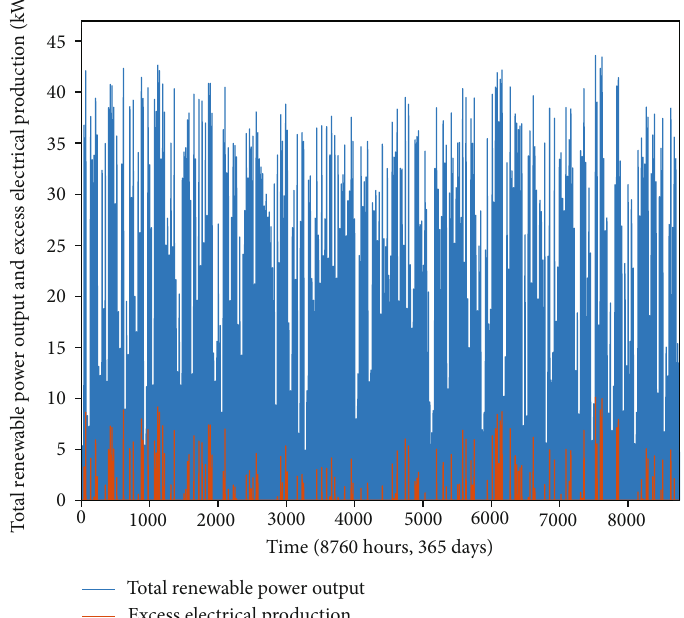
Figure 29: Aggregate renewable output power against excess electrical generation of the grid-PV small grid system without storage.